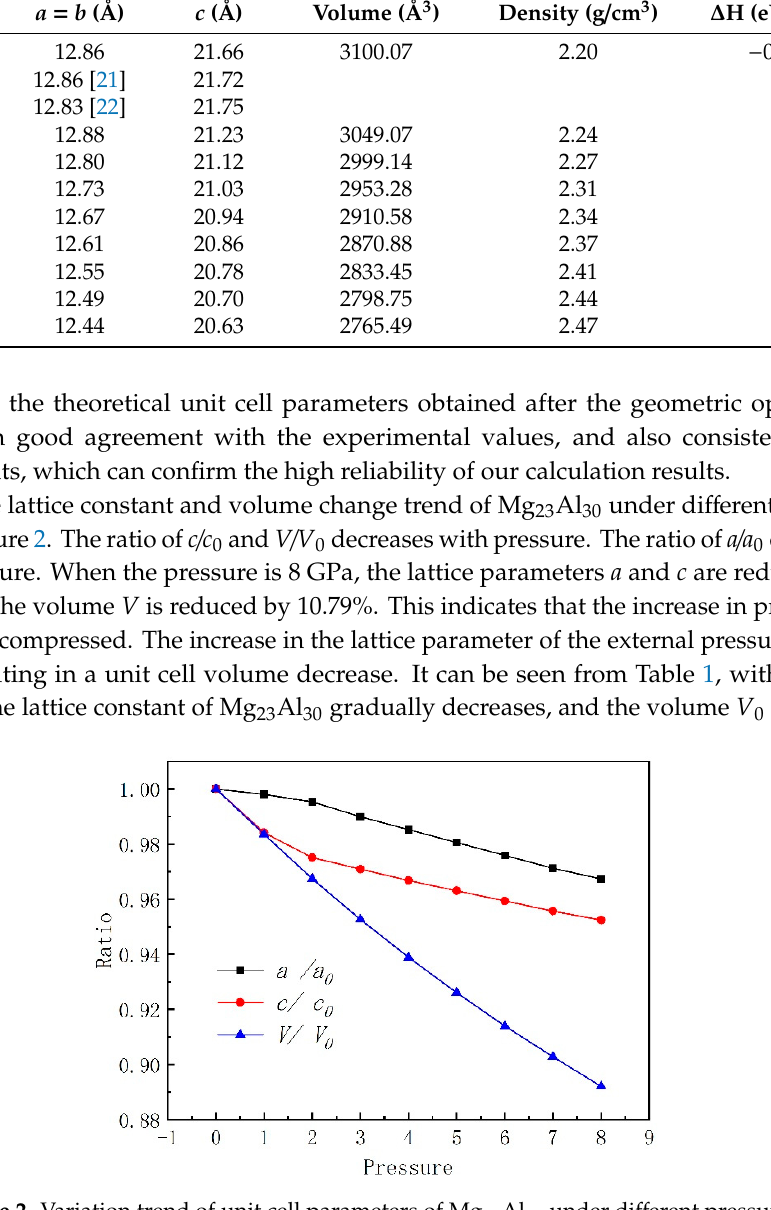
Table 1. The calculated parameters of Mg 23 Al 30 under di ff erent pressures (pressure range: 1–8 GPa).